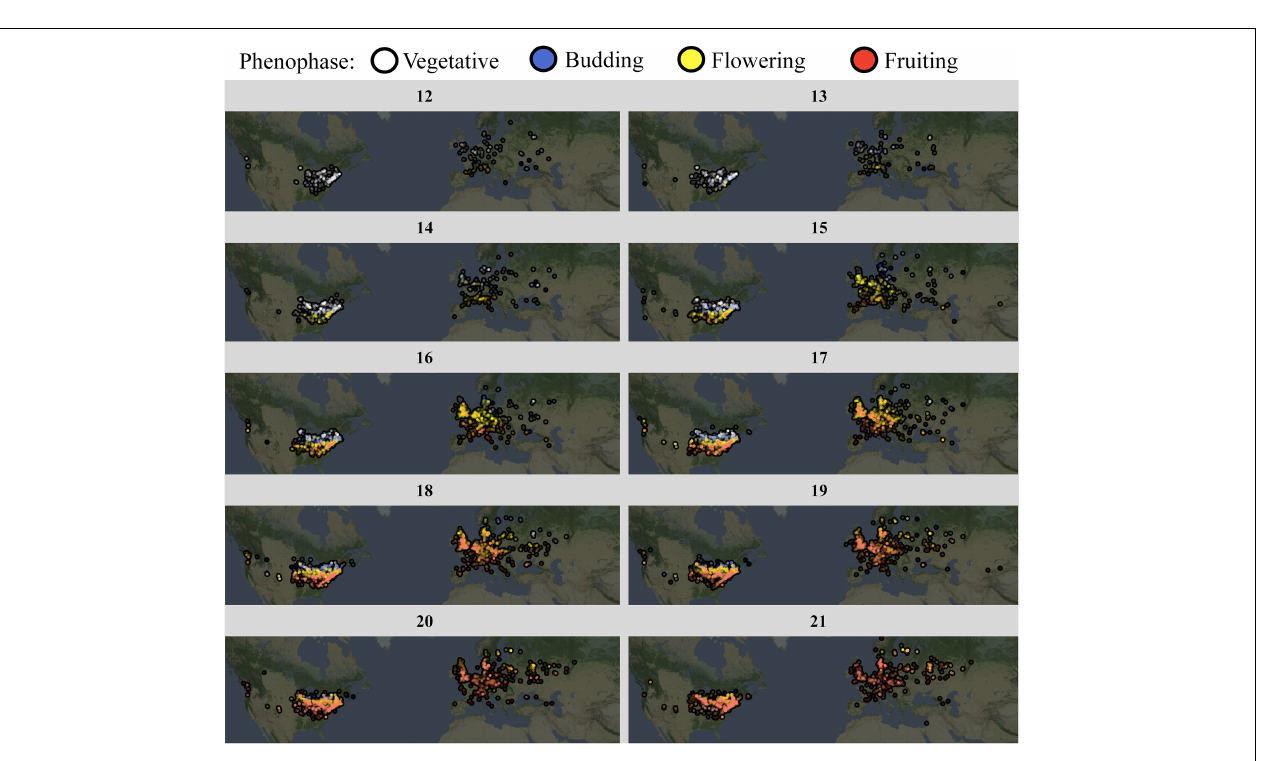
Frontiers in Plant Science |